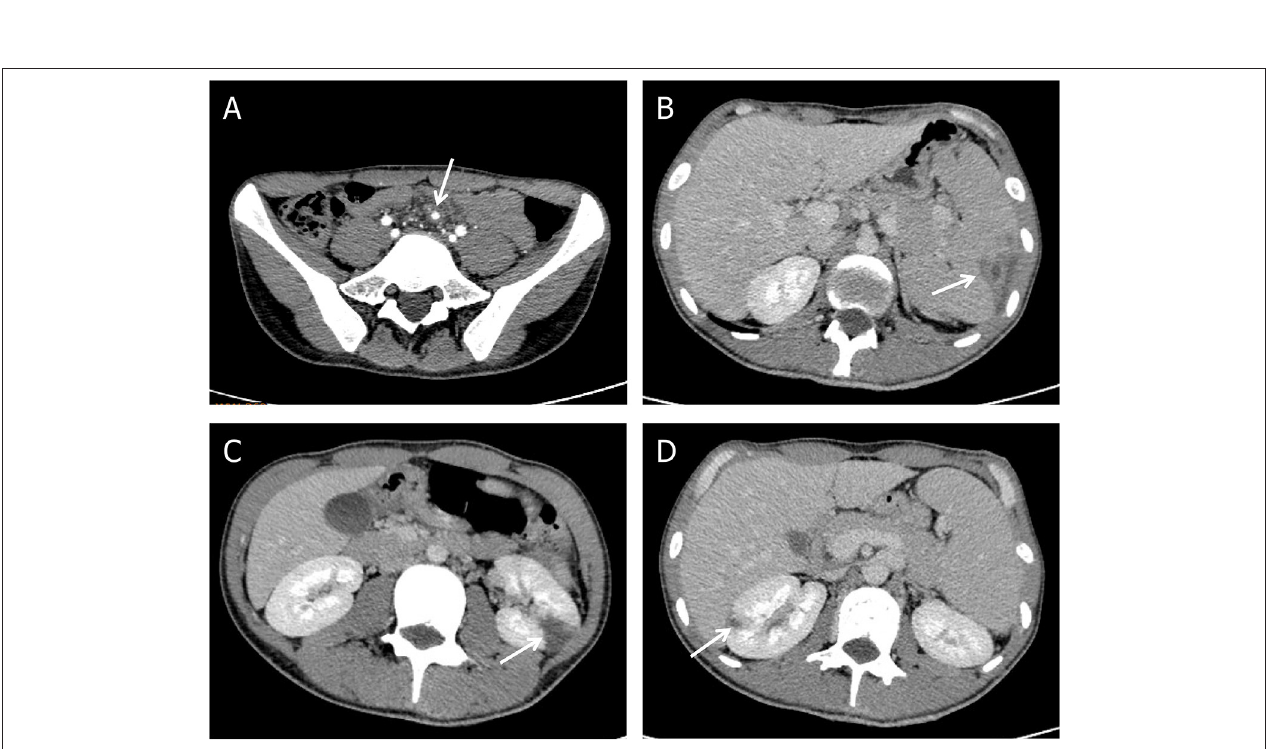
FIGURE 3 | Complications of Abiotrophia defectiva infective endocarditis. (A) Mesenteric arterial branch aneurysms in abdomen CT. (B) Splenic infarction in abdomen CT. (C,D) Multiple renal infarction in abdomen CT.